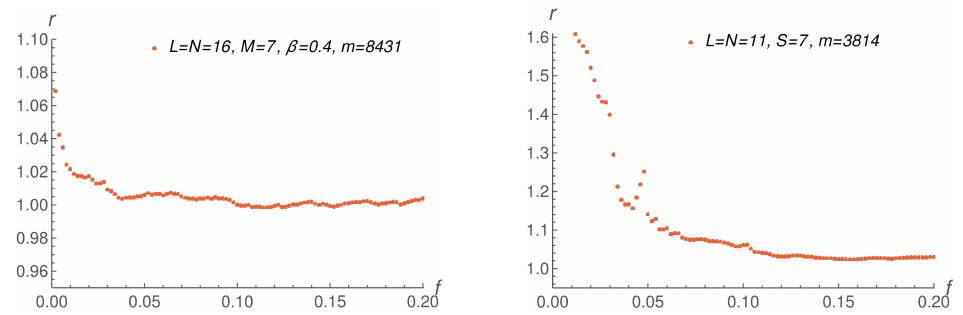
Figure 11: Variation of the best fit parameter α in the β -deformed theory, with 8% (4%) clipping of low-(high-) energy states. On the left we vary the number of bins n used for obtaining the distribution of spacings, with a fixed degree for the polynomial unfolding. On the right we vary the degree p used for the polynomial unfolding of = 50. The results are rather insensitive to variations in these the spectrum, with n b ≥ 20. parameters, as long as p ≥ 11 and n b